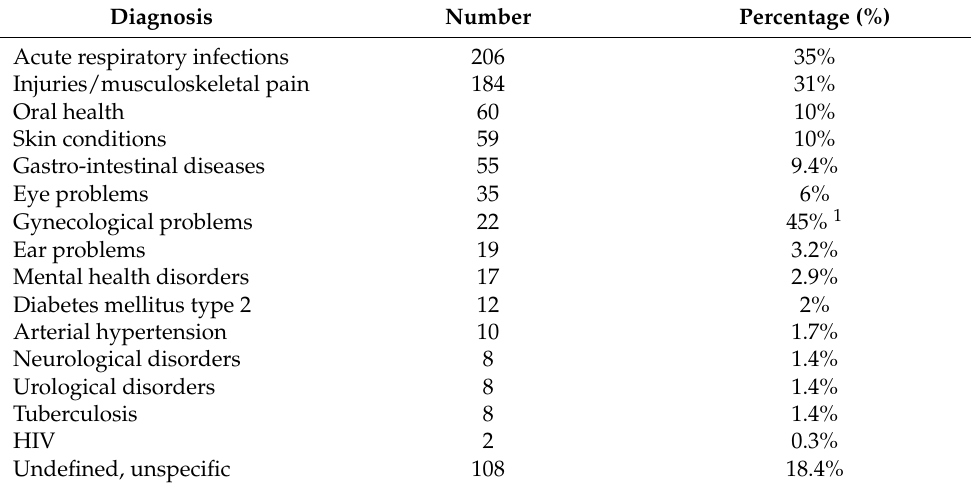
Table 2. ICD-based burden of disease at the EMERGENCY